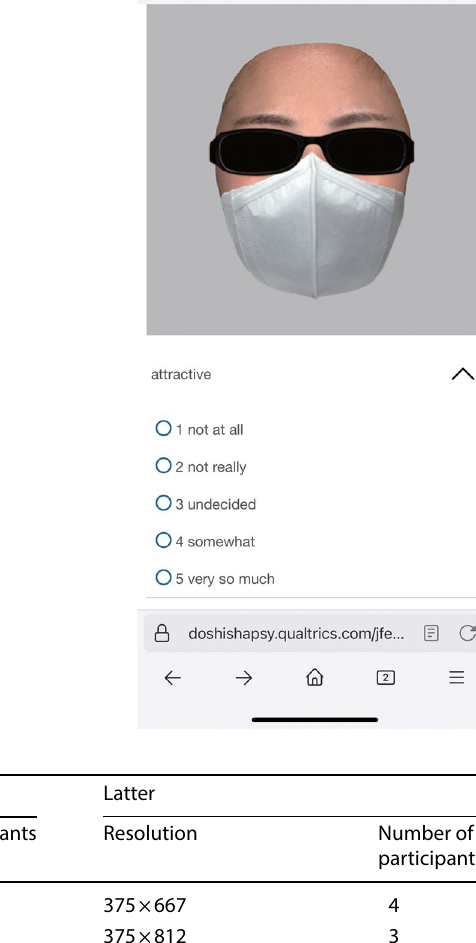
Fig. 2 A screenshot of experi- ment using Qualtrics on a smartphone